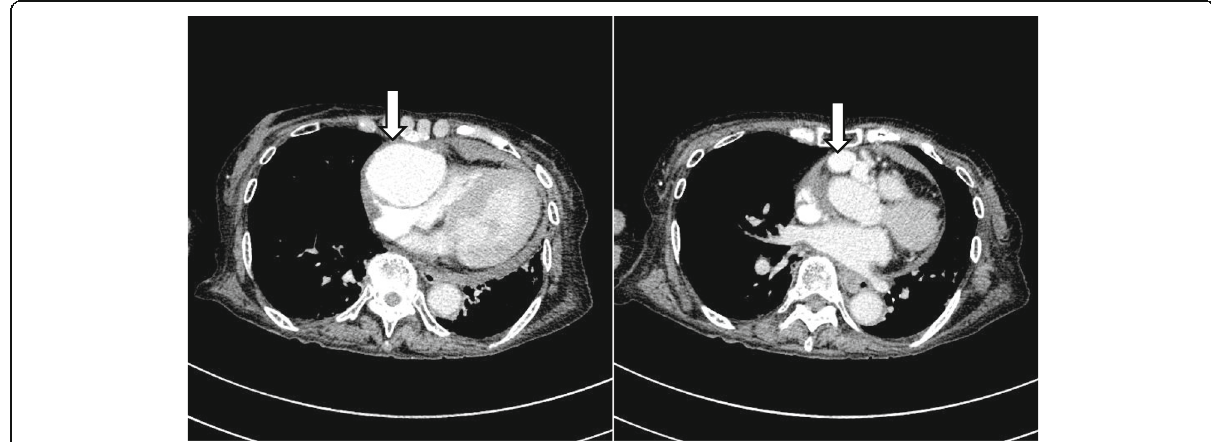
Fig. 1 Initial computed tomography of the chest. Computed tomography of the chest shows multiple aneurysmal masses (arrows) in front of the heart communicating proximally with the right coronary artery